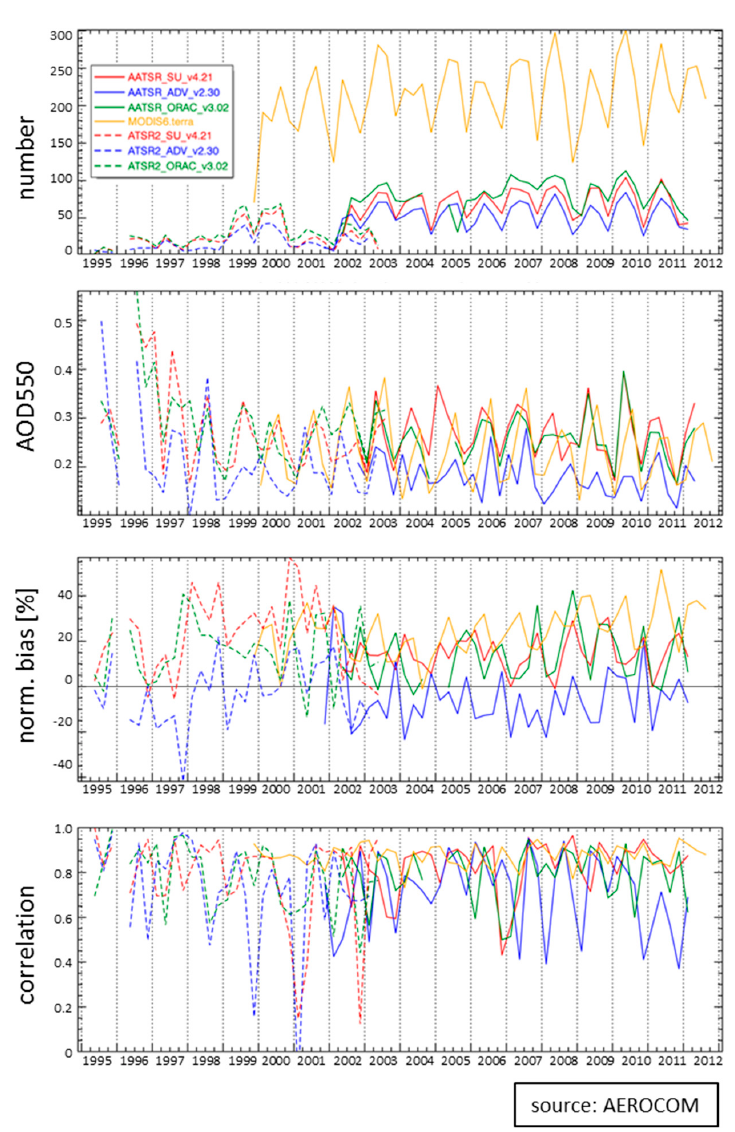
Figure 6. Time series over the eight long-term AERONET sites (for three ATSR algorithms and MODIS Terra collection 6). From top to bottom: number of data points, seasonal mean AOD550, modified normalized mean bias, Pearson correlation. Note, that ADV usually misses the one station in a desert region, Sede Boker.